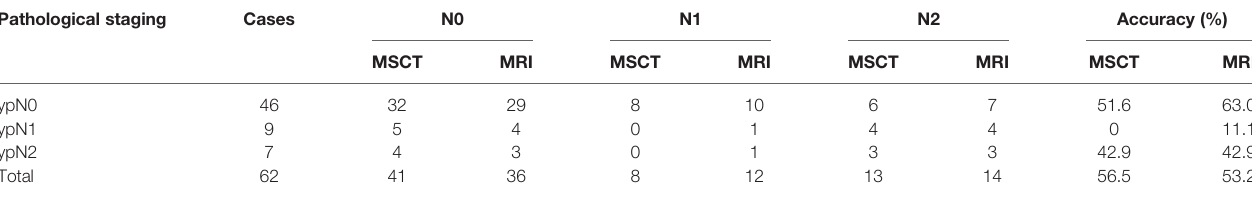
TABLE 5 | Diagnostic results of MSCT, MRI, and pathological examination for N restaging of rectal cancer after NCRT. Pathological staging